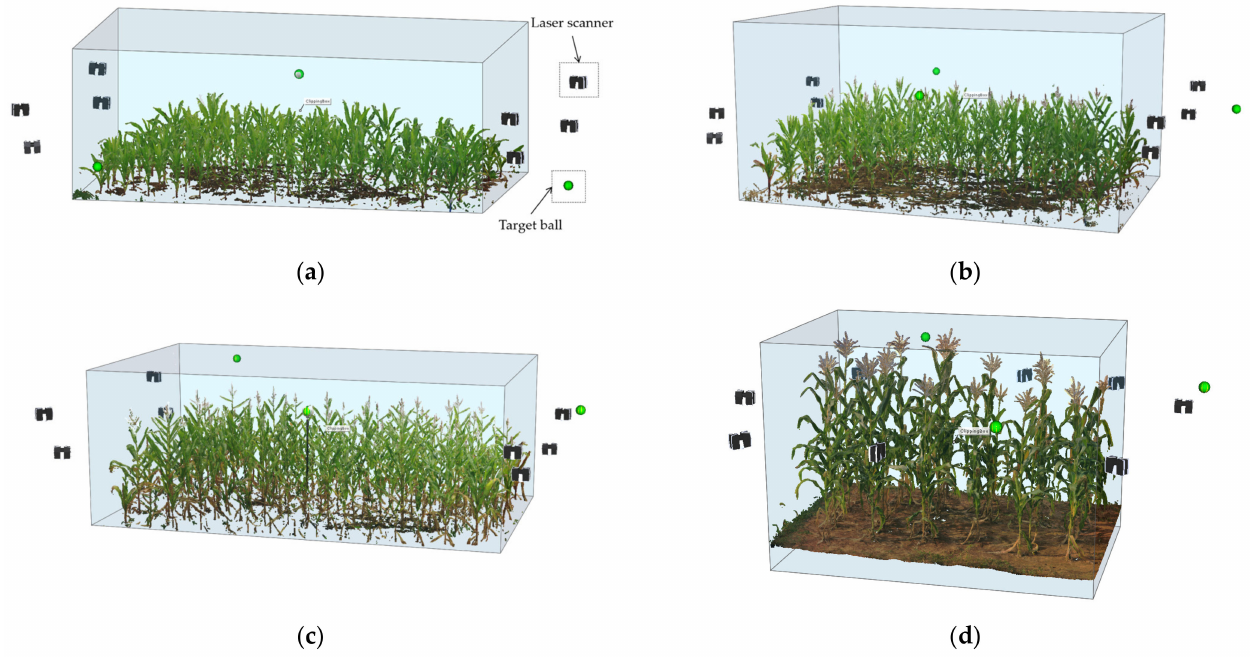
Figure 1. Experimental scene diagram of target 3D point cloud acquisition. The picture contains the placement of the laser scanner and the target ball. ( a ) Maize-01 ; ( b ) Maize-02 ; ( c ) Maize-03 ; ( d ) Maize-04 . Table 1. Field maize point cloud data